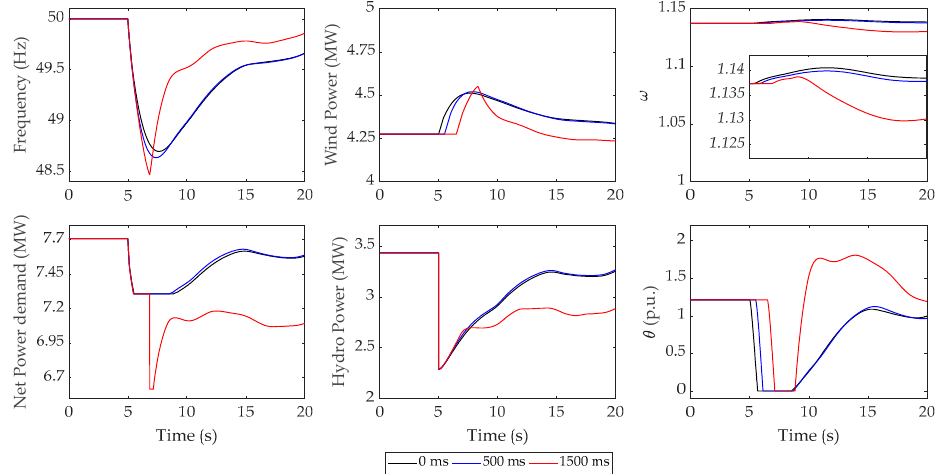
Figure 10. Dynamic system response considering the R1 VSWT contribution, assuming different R1 action delays when the “biggest operating unit” outage takes place.